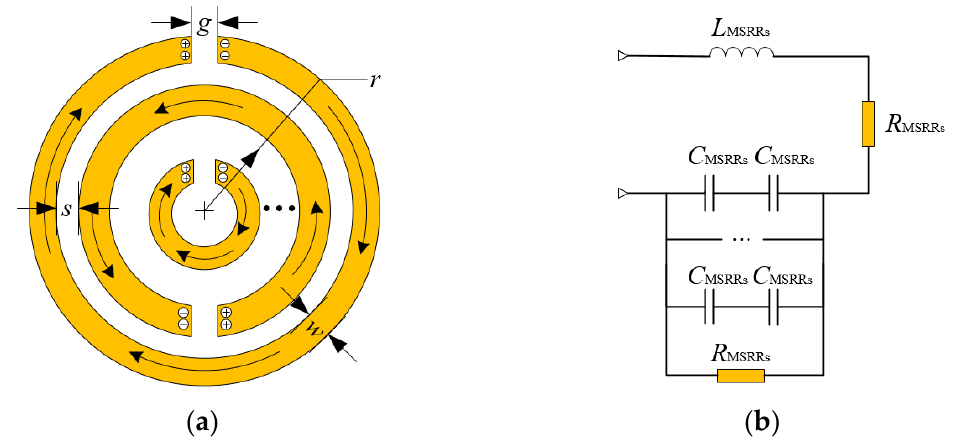
Figure 1. ( a ) Current flow diagram; ( b ) equivalent circuit